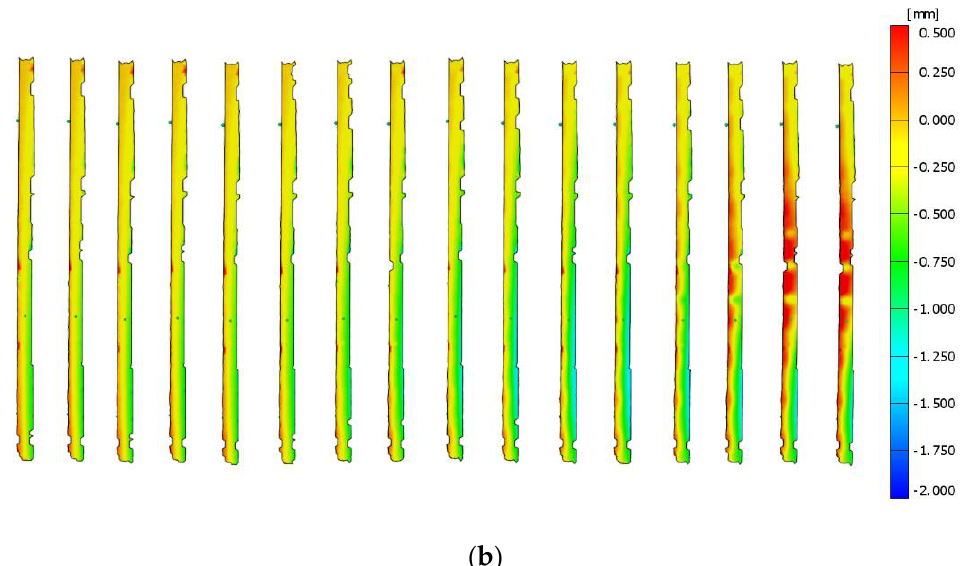
Figure 8. ( a ) ARAMIS test results for column B4—web displacement. ( b ) ARAMIS test results for column B4—flange displacement.